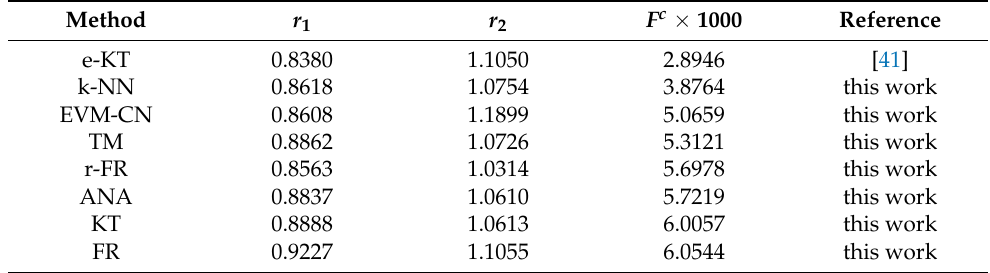
Table 21. The reactivity ratios obtained for copolymerization of NPEA-NVP [39].